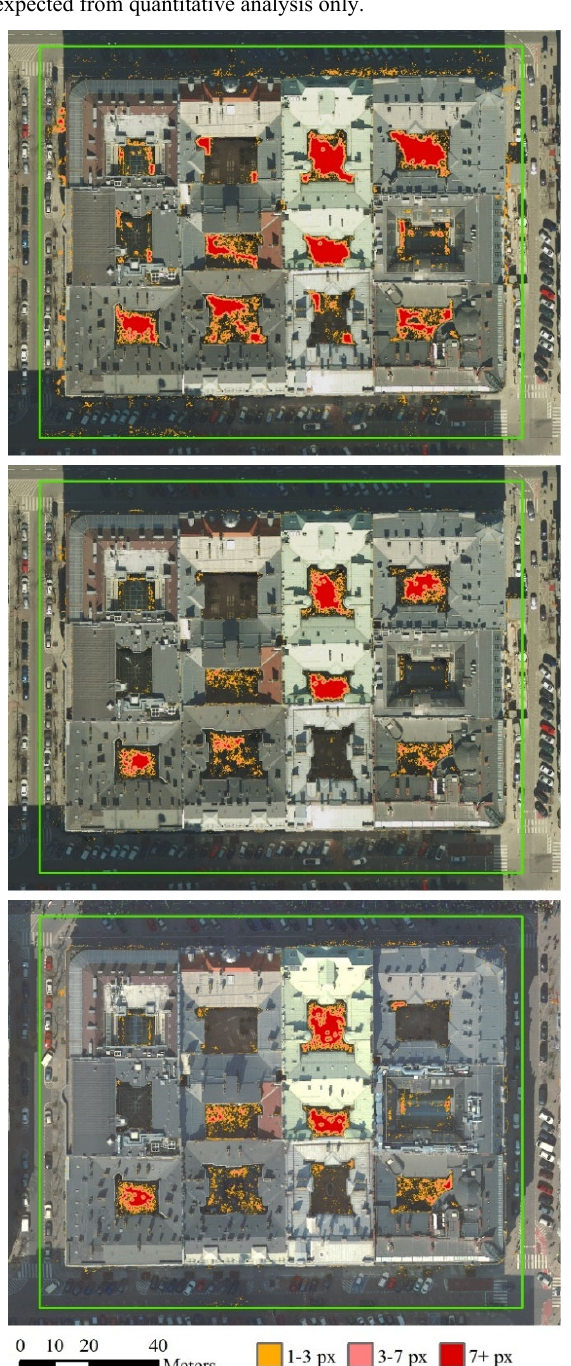
Figure 6. True orthophotos with classified interpolation distance for the 5 th test area (marked with the green outline) from top: 2018 (80/60); 2018 (80/80); 2019 (80/80).